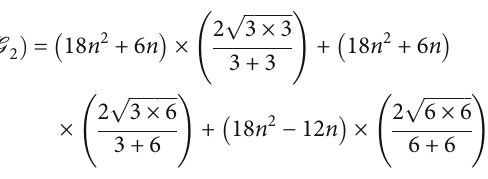
p 3+3 − 2/3×3 p 3+6 − 2/3×6 p 6+6 − 2/6×6